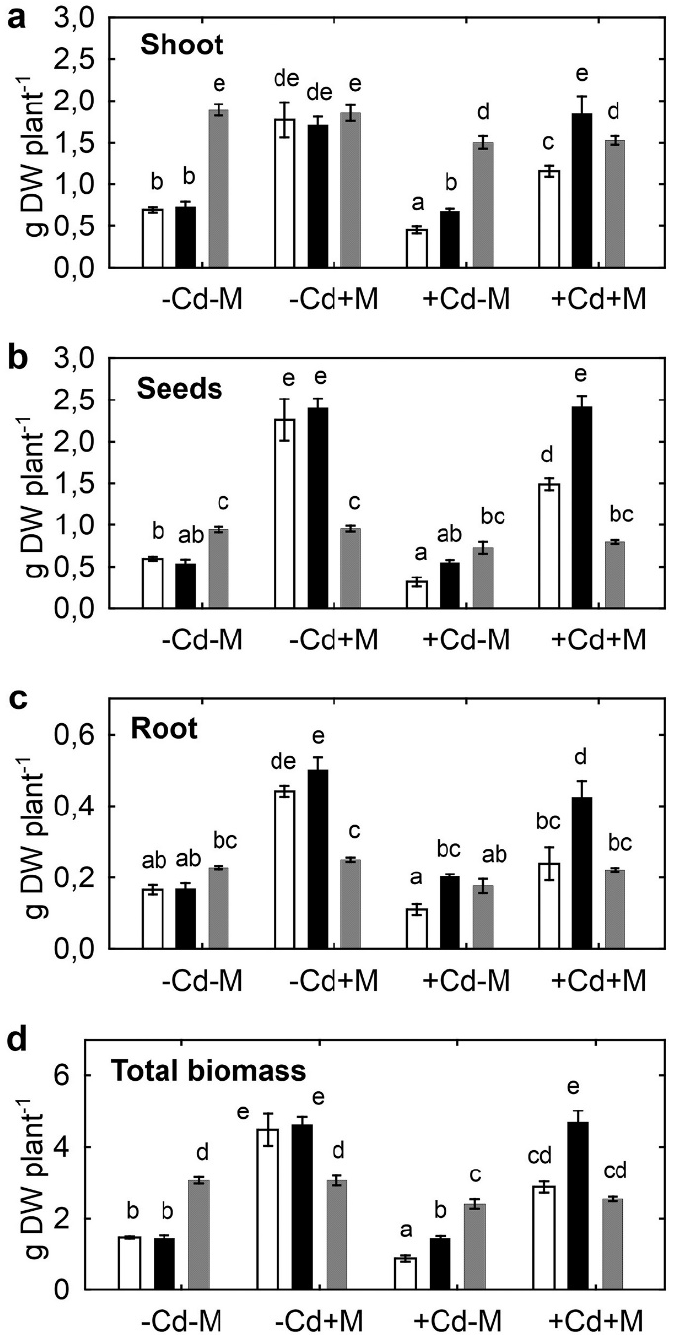
Figure 1. Shoot ( a ), seeds ( b ), root ( c ), and total ( d ) biomass of pea SGE (unfilled columns), SGECd t (filled columns), and B. juncea (gray columns) grown in uncontaminated or Cd-supplemented soil. Treatments: -Cd-M—uncontaminated soil with uninoculated plants, -Cd+M—uncontaminated soil with inoculated plants, +Cd-M—Cd-supplemented soil with uninoculated plants, +Cd+M—Cd-supplemented soil with inoculated plants. Plants were inoculated with a microbial consortium consisting of Variovorax paradoxus 5C-2, Rhizobium leguminosarum bv. viciae RCAM1066, and Glomus sp. 1Fo. Vertical bars show standard errors. Different letters show significant differences between treatments (least significant difference test, p < 0.05, n = 20). DW stands for dry weight. Plants were analyzed on the 83rd day after planting.